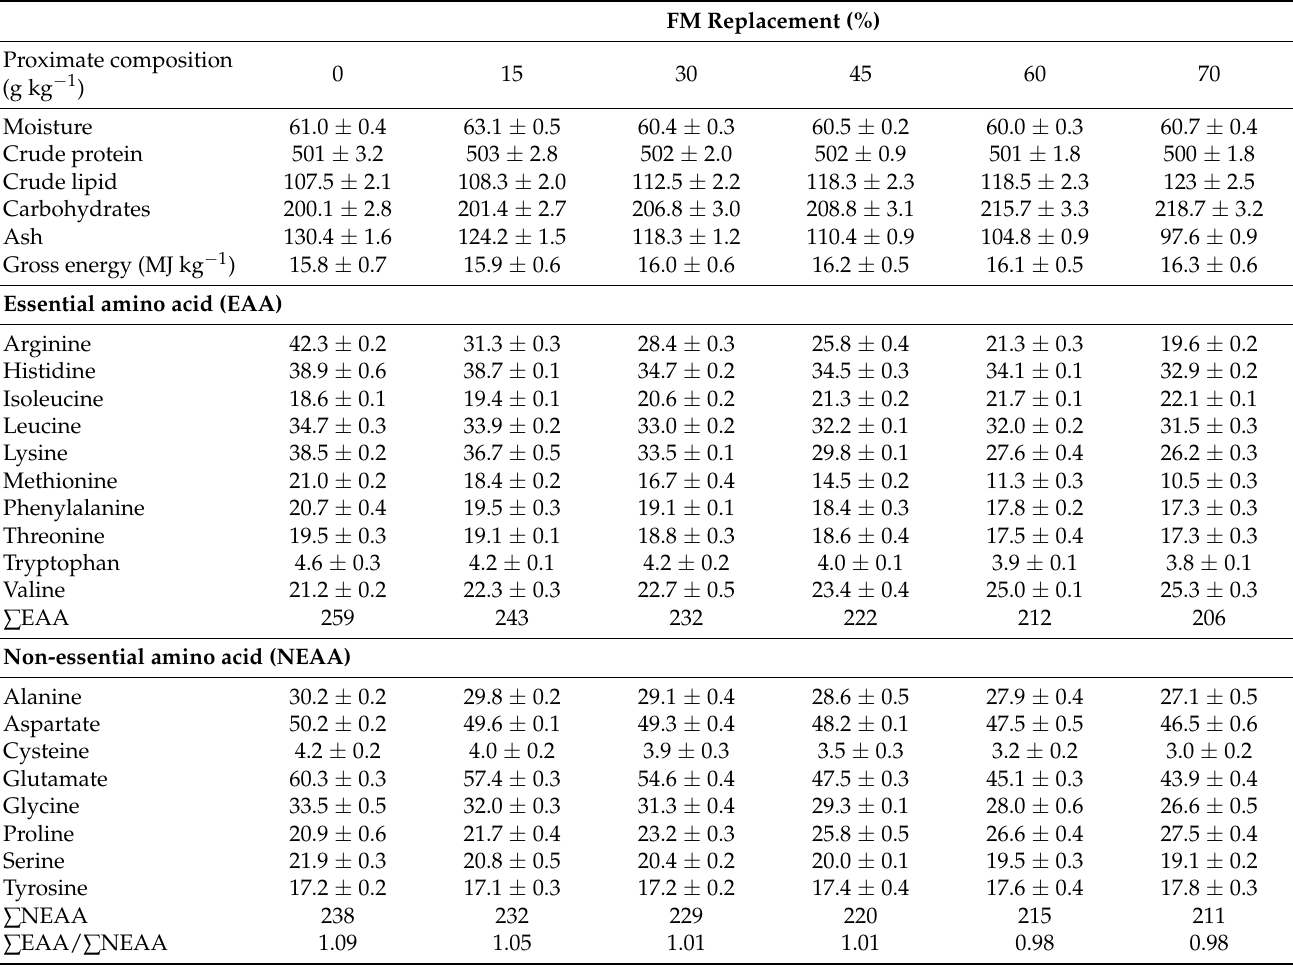
Table 4. Proximate composition (g kg − 1 diet) and amino acid profiles of practical diets with different levels of replacement of fishmeal (FM) by black soldier fly larvae meal